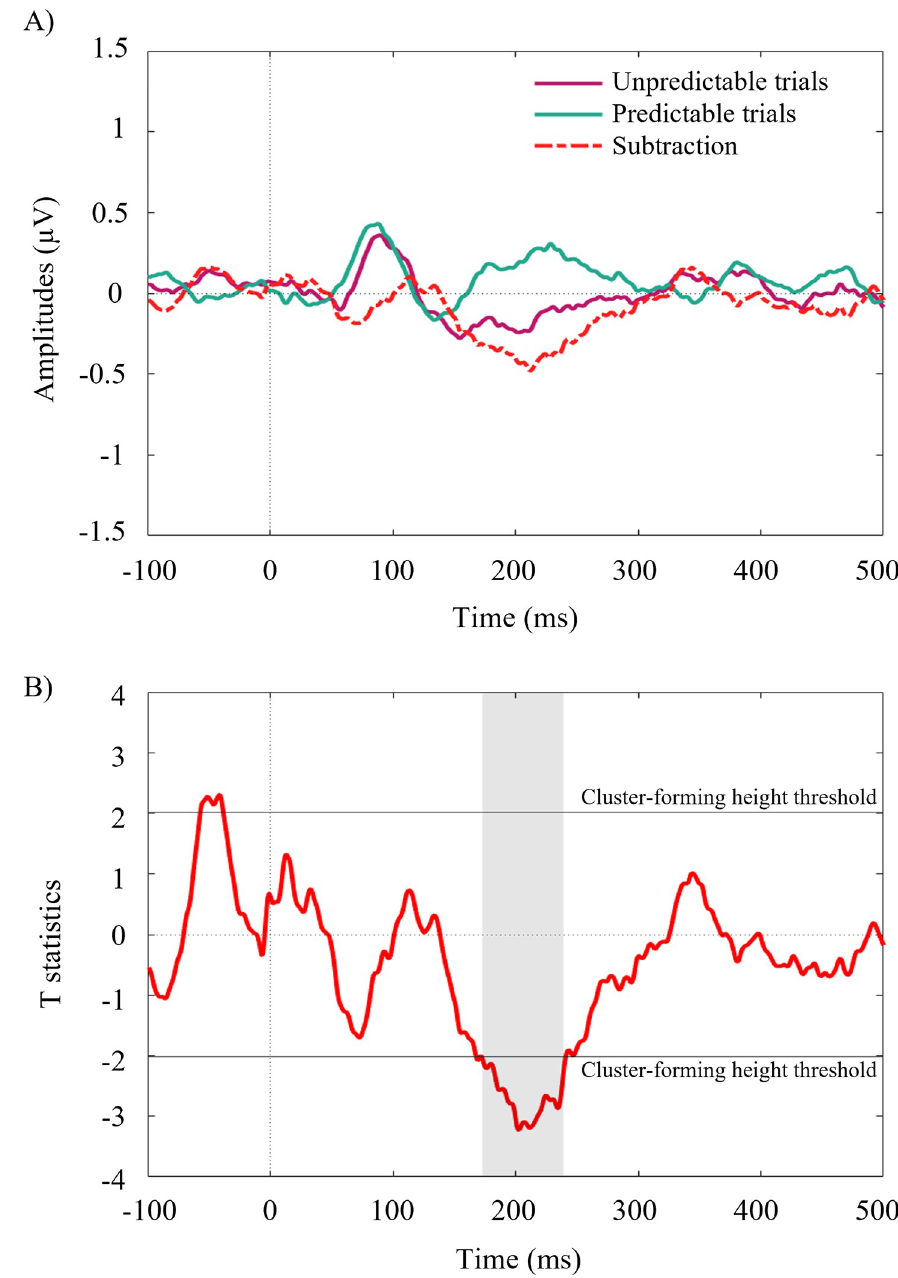
Fig 4. Temporal cluster permutation. A) Grand averaged N2pc amplitudes ( μ V) pooled across both predictable conditions and both unpredictable conditions, and the subtraction (difference) waveform of unpredictable minus predictable conditions. B) T statistics for the predictable and unpredictable conditions analysed with the temporal clustering permutation method. The sole significant temporal cluster from 173ms to 239ms is denoted by grey